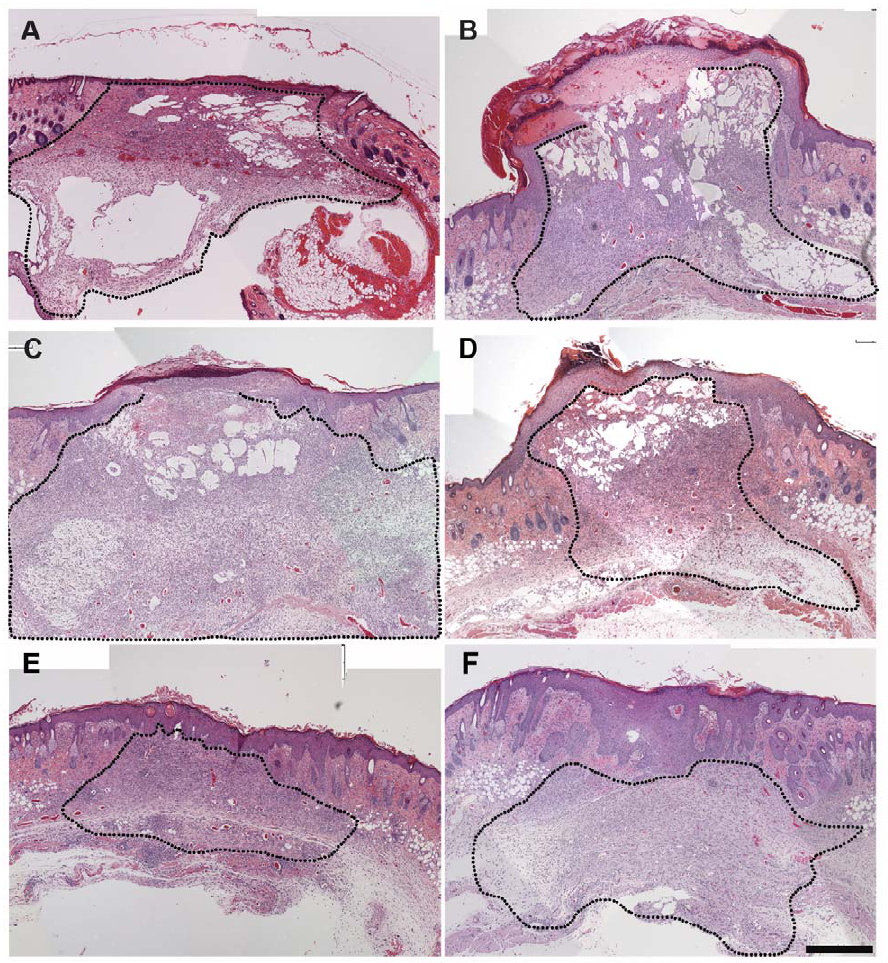
Figure 6. Histological evaluation of wound healing effects of the peptides in CY-treated Balb/c mice. Animals were either wounded and treated with CMC (A) or injected with CY 1 and 4 days prior to injury, wounded and treated with CMC alone (B), with Regranex (C), with UN3 (D), comb1 (E) or a combination of UN3 and comb1 (F). Wounds were excised at day 10 post-injury, formalin-fixed, sectioned and stained with haematoxylin and eosin. Dotted line delineates the wound bed. Scale bar 500 m m.